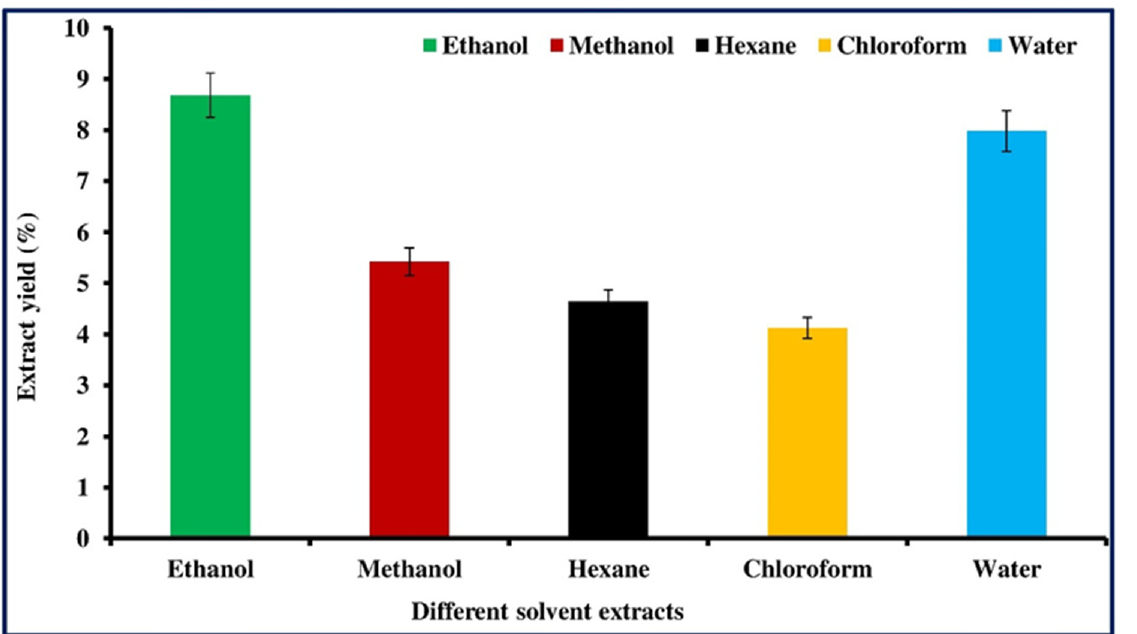
Figure 1. Different solvent extracts yield of Martynia annua Linn . mentioned values are mean and standard error of triplicates.